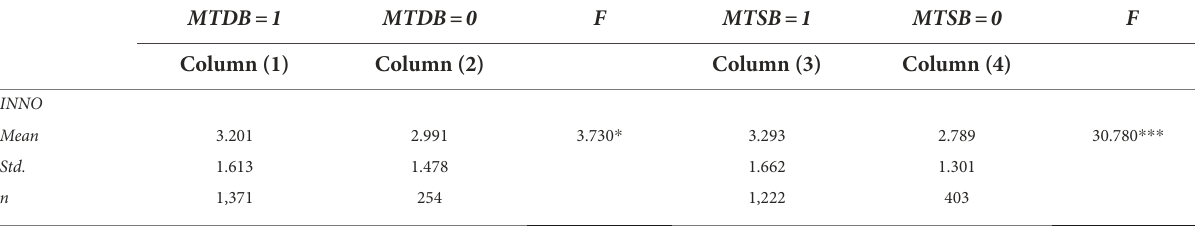
TABLE 4 One way ANOVA between dual network embedding balance and firms’ innovation.